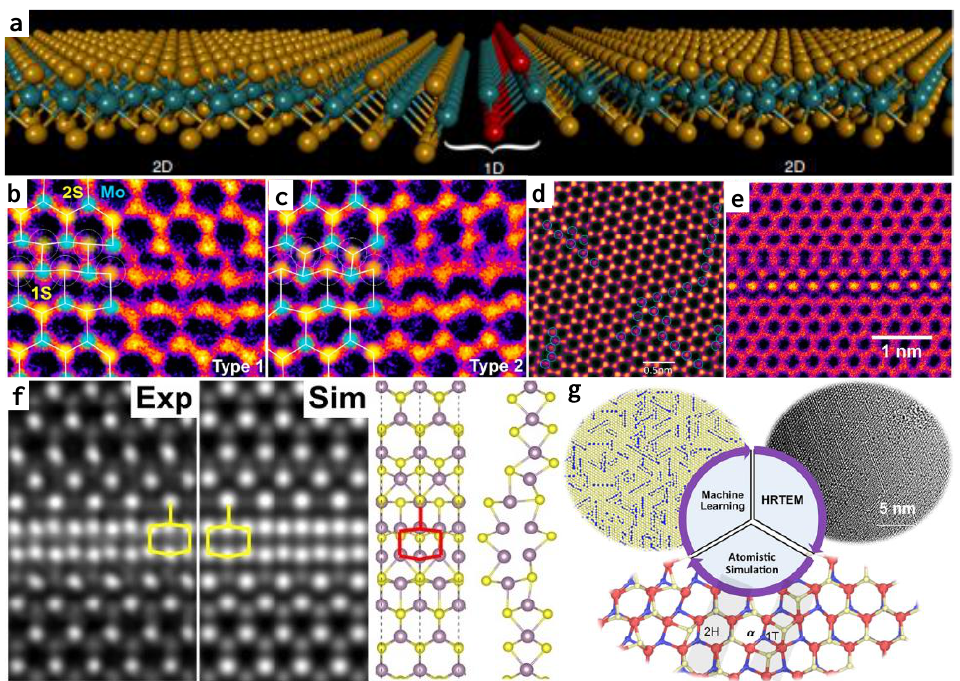
Figure 1. ( a ) Perspective view of an atomic model of the 1D vacancy line consisting of 2S missing atomic rows. ( a ) Adapted with permission from [7]. Copyright Springer Nature 2011. ( b , c ) Two different types of S atom reconstructions with different amounts of lattice compression. ( b , c ) Adapted with permission from [12]. Copyright 2014 American Chemical Society. ( d ) AC-TEM image showing the aggregation of S vacancies into extended line defects along a zigzag path with different lengths and widths. ( e ) Higher-magnification AC-TEM images at 800 °C of an ultralong line defect in MoS 2 showing uniform atomic periodicity. ( d , e ) Adapted with permission from [13]. Copyright 2018 American Chemical Society. ( f ) Experimental (Exp.) and simulated (Sim.) images of the Mo chain in MoS 2 and the corresponding atomic model. ( f ) Adapted with permission from [13]. Copyright 2018 American Chemical Society. ( h ) Defect dynamics in 2-D MoS 2 probed by using machine learning, atomistic simulations, and high-resolution microscopy. ( h ) Adapted with permission from [16].